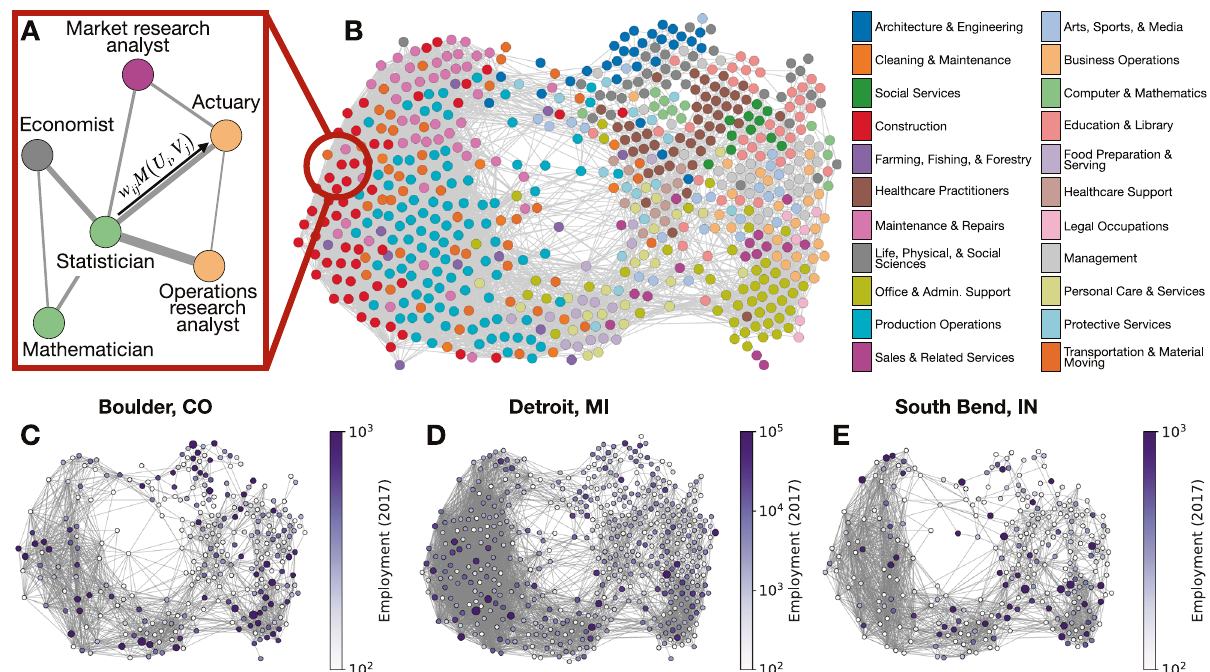
Fig. 1 The job connectivity for visualizing urban labor markets. A A schematic for skill similarity w ij and the job matching process. B The job network constructed from skill similarity scores. Each occupation is represented by a circle colored according to sector. This job network visualization is fi ltered to links with w ij > 0.70; the complete job network was used in all analysis. C – E Example cities are projected onto subsets of the job network based on employment by occupation in